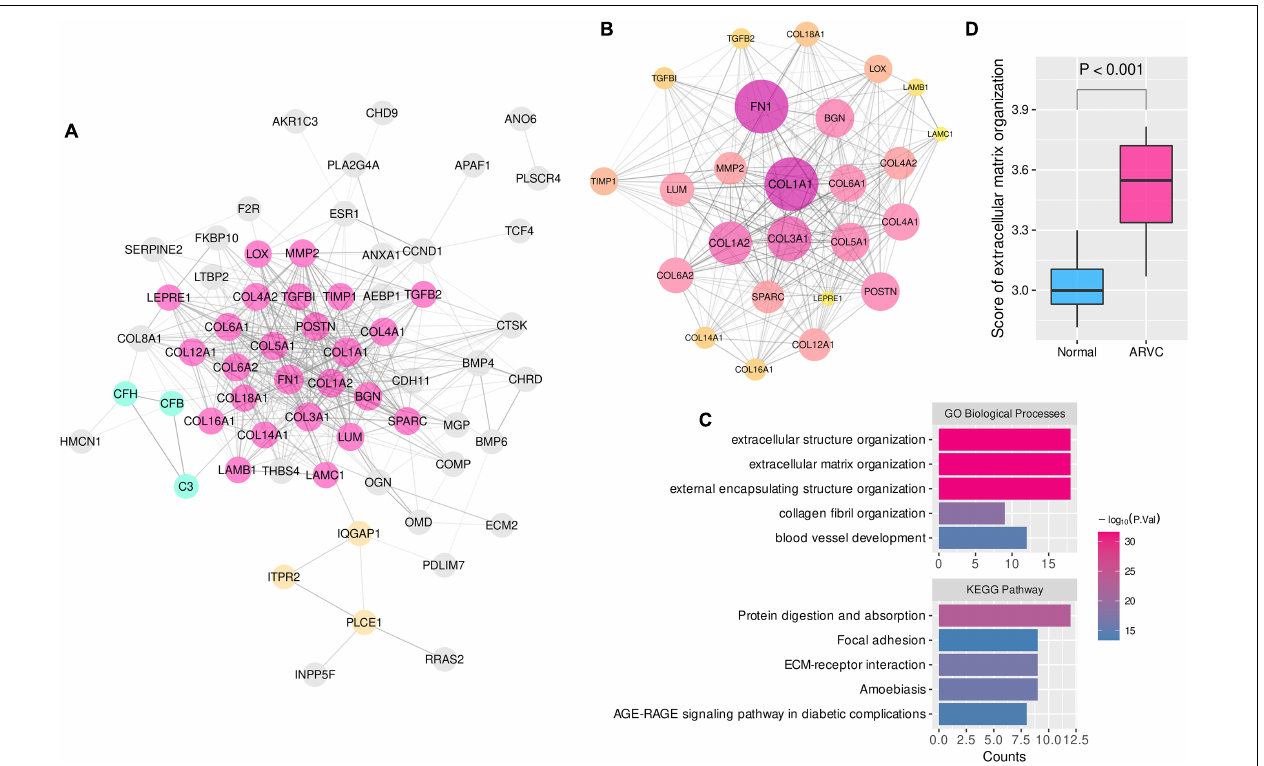
FIGURE 3 | The PPI network and enrichment analysis of ARVC hub genes. (A) The PPI network of 62 candidate hub genes from the three ARVC hub modules (disconnected nodes were hided). (B) The primary cluster with 25 ARVC hub genes in the PPI network, larger node sizes represent higher connection degrees within the network. (C) Functional enrichment of the 25-hub-gene cluster. (D) Comparison of the ssGSEA score of extracellular matrix organization between ARVC and normal samples. ssGSEA, single sample gene-set enrichment analysis. GO-BP, Gene Ontology biological